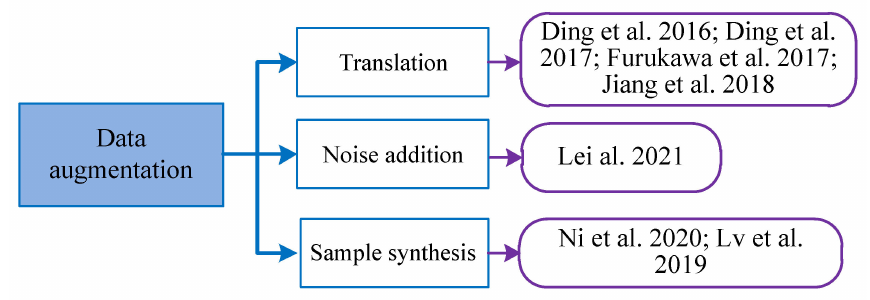
Figure 12. Data augmentation methods in SAR ATR